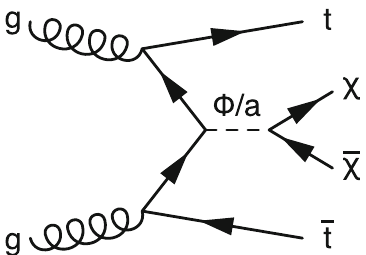
Fig. 1 Diagrams of top squark pair production with further decay of eachtopsquarkintoatopquarkandaneutralino(left),ofeachtopsquark into a chargino and a neutralino, with the chargino decaying then into